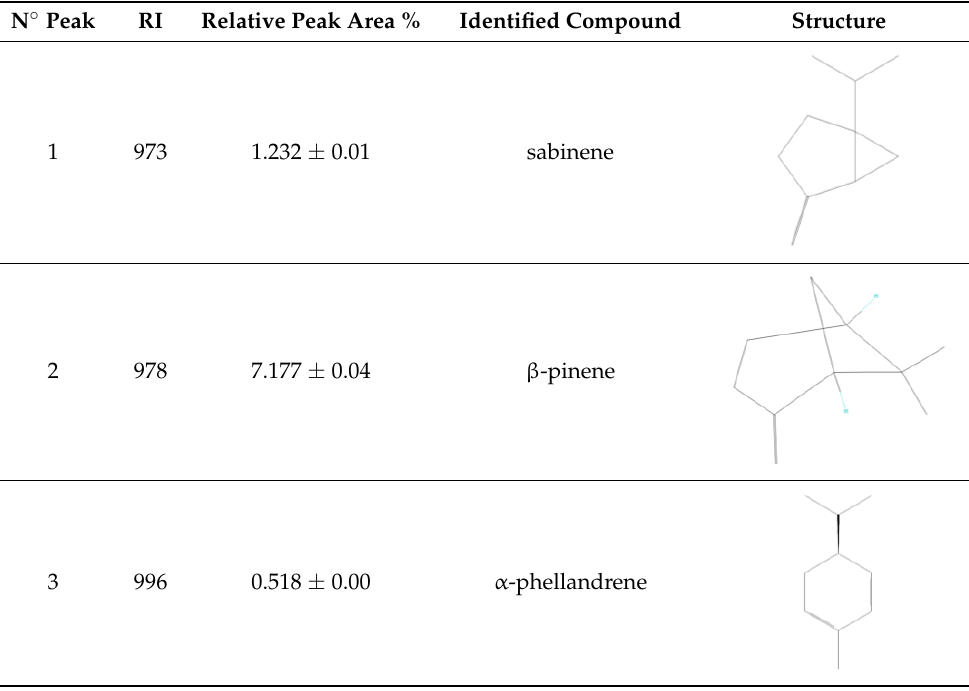
Table 1. Chemical composition of thyme essential oil.